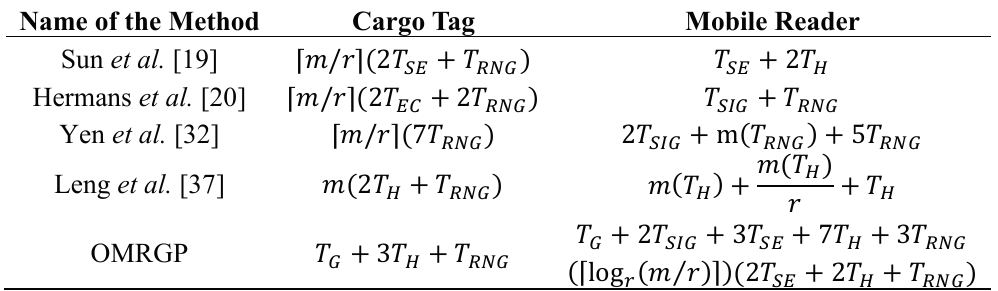
Table 4. Computational capacity of grouping proof tags (with m number of